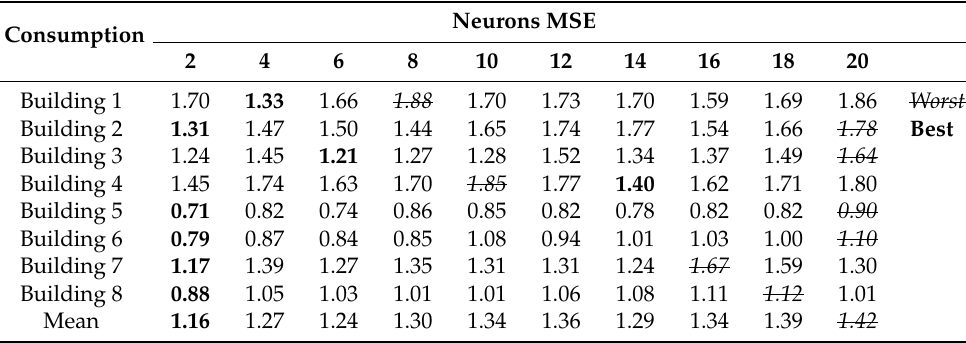
Table 3. MSE of the delay parameter obtained with the NARX